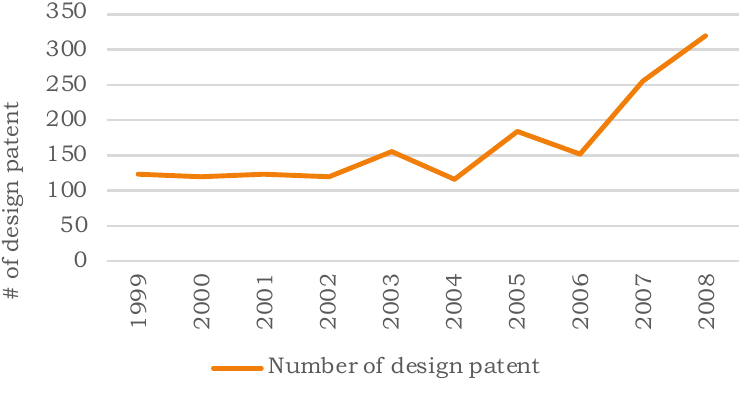
Figure 2. Transition of design patent